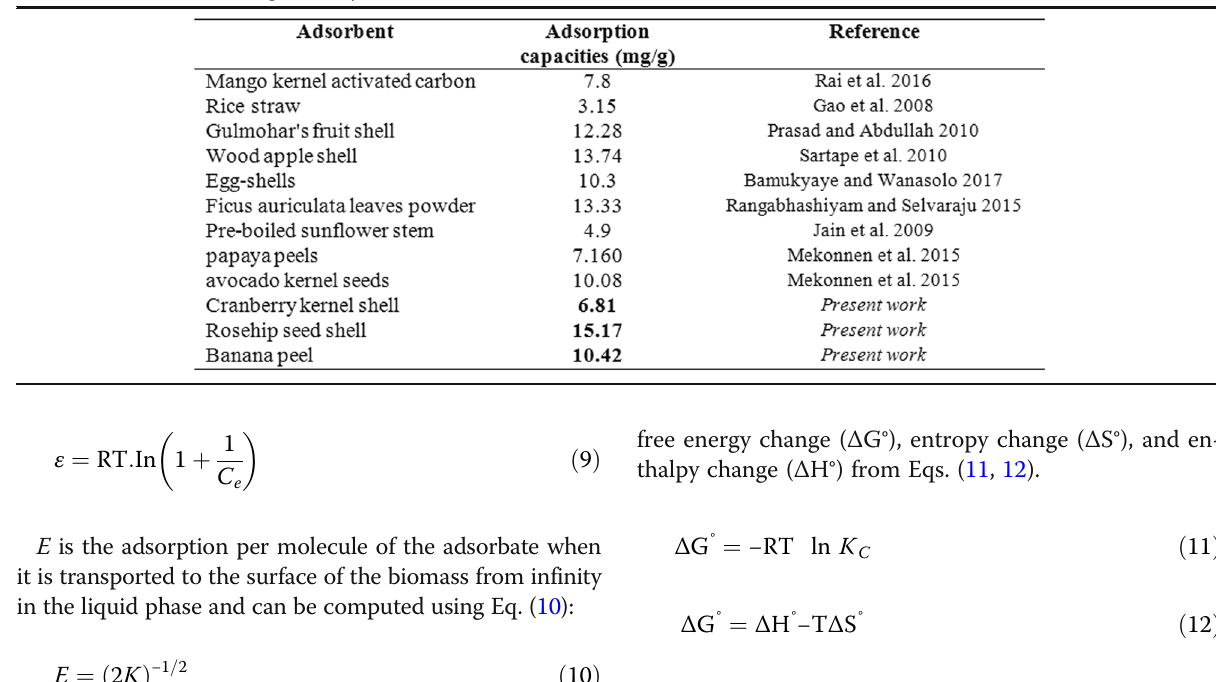
Table 2 Cr(VI) removal using a variety of low-cost adsorbents